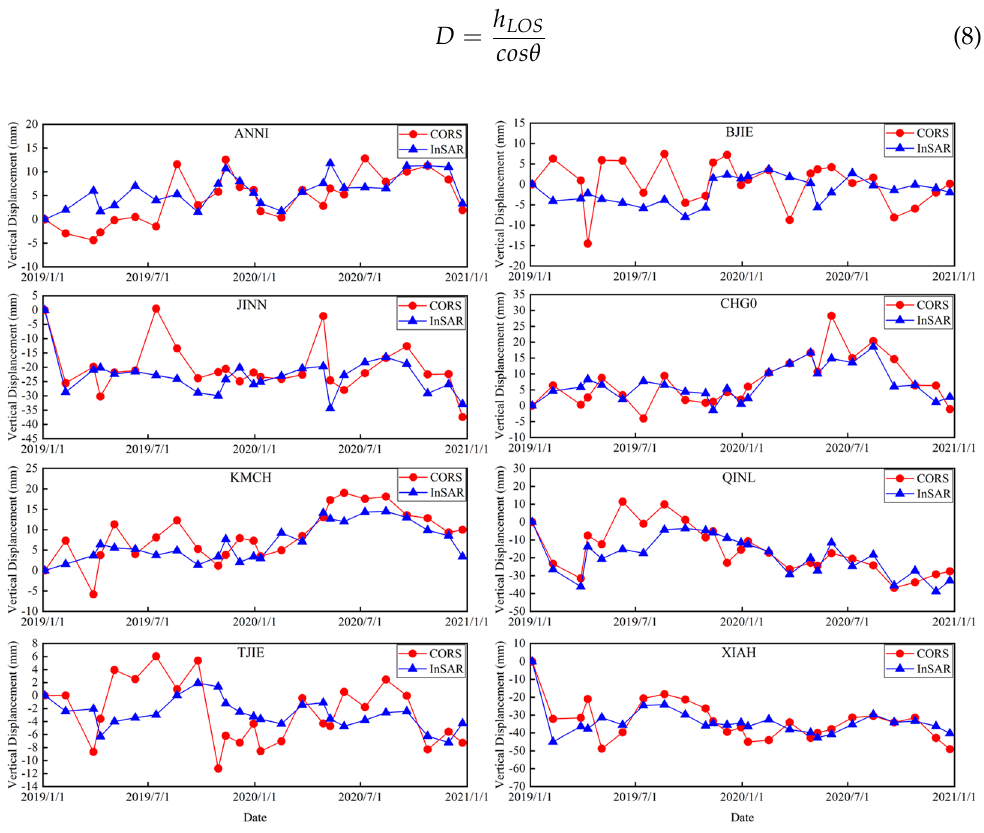
Figure 11. Comparison diagram of CORS sites and InSAR time series cumulative shape variables.